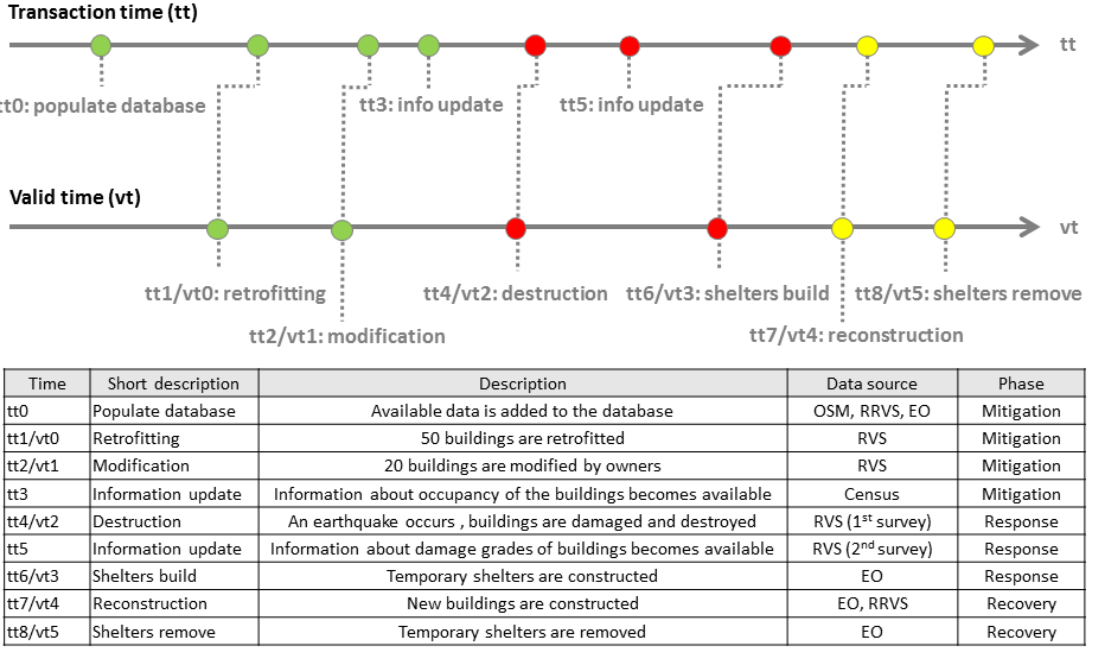
Figure 7. Transaction and valid timelines of the application scenario and overview of the events considered in the application scenario.